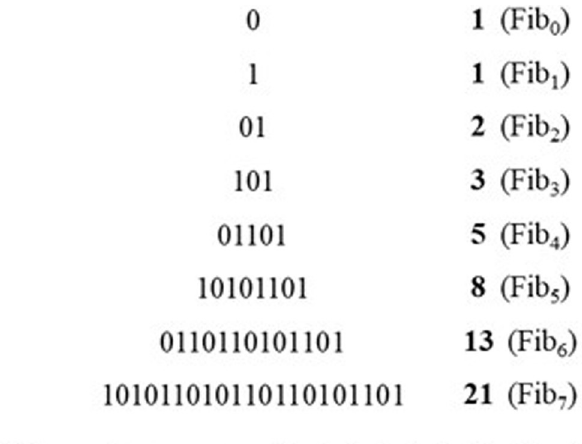
Fig 1. Graphical representation of a sequence produced by the Fibonacci grammar, where Fib n indicates each generation of the grammar.